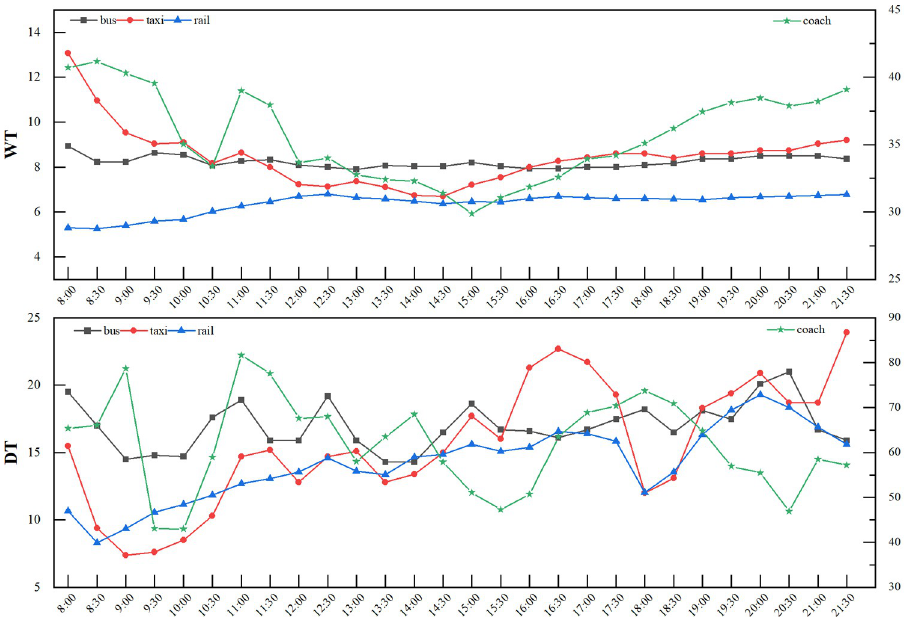
Fig 5. Time-varying chart of the index data of each connection area on September 30 (WT, DT).